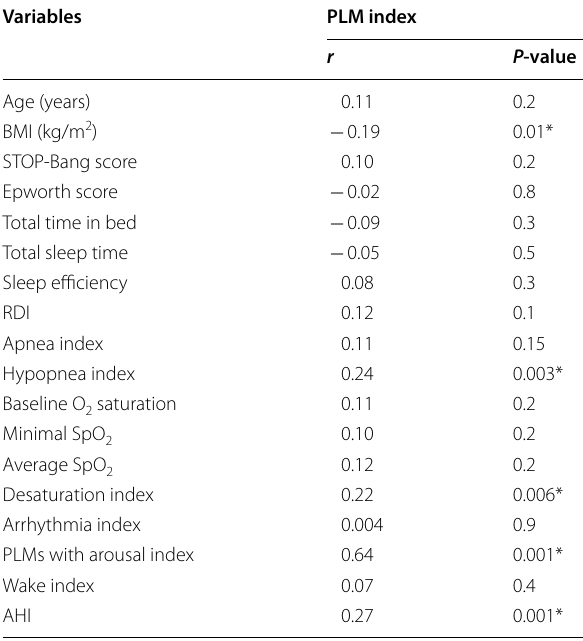
Table 4 Correlation between PLM index with study parameters among cases